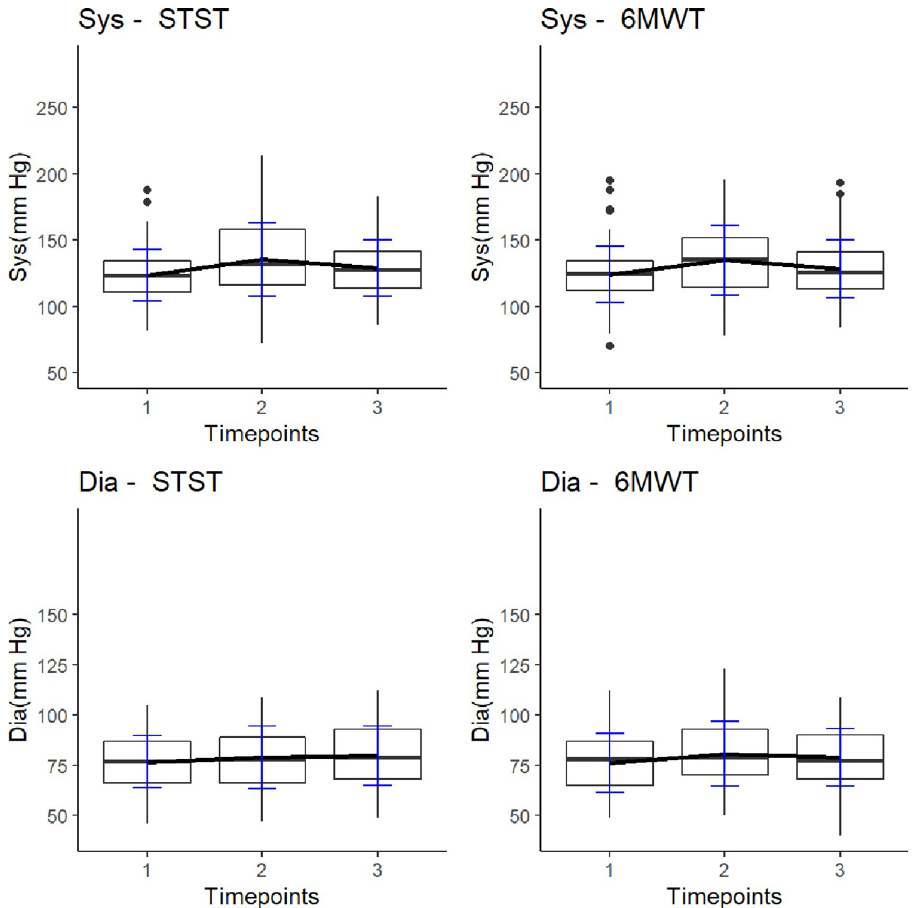
Fig 3. Line charts and box plots illustrating heart rate and SpO 2 –STST versus 6MWT. Timepoints: 1 = before test, 2 = immediately after test performance, 3 = three minutes after test. Each box plot displays the following information: The heavy central line is the median value, the bottom and top lines of the box are the first and third quartiles of the data and individual dots are outlier data. Abbreviations . HR = heart rate; bpm = beats per minute; SpO 2 = peripheral oxygen saturation; STST = sit-to stand test, 6MWT = six-minute walk